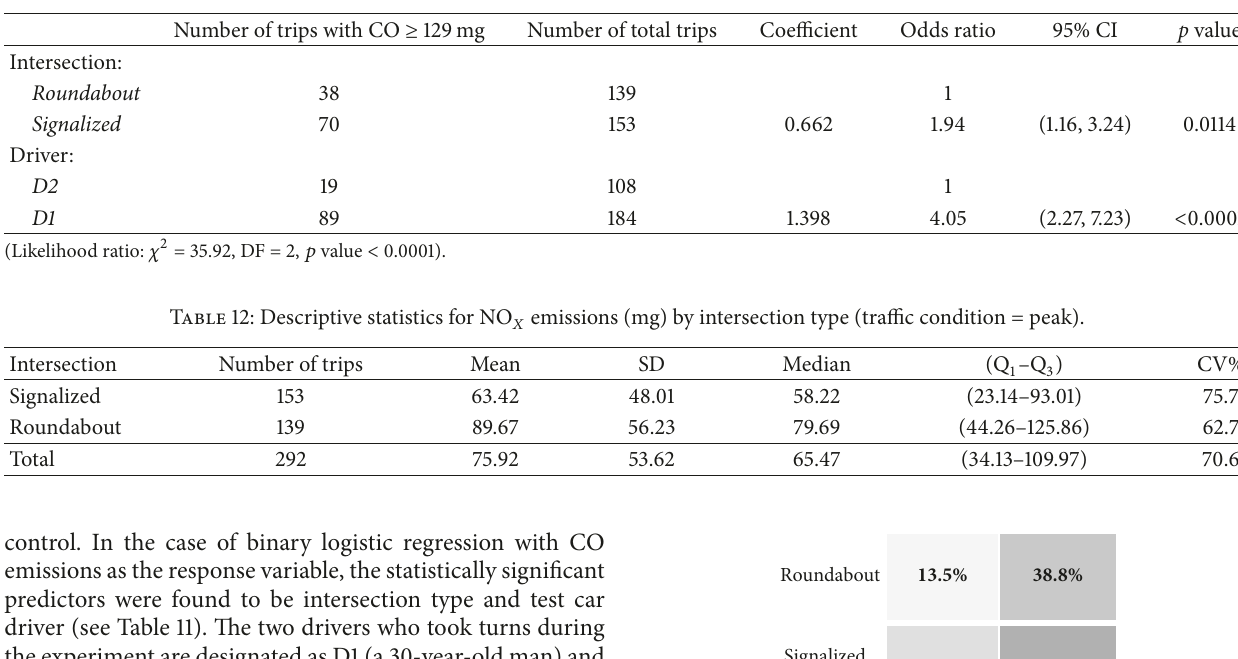
Table 11: Logistic regression relating risk of “high” CO emissions to intersection type and test car driver.